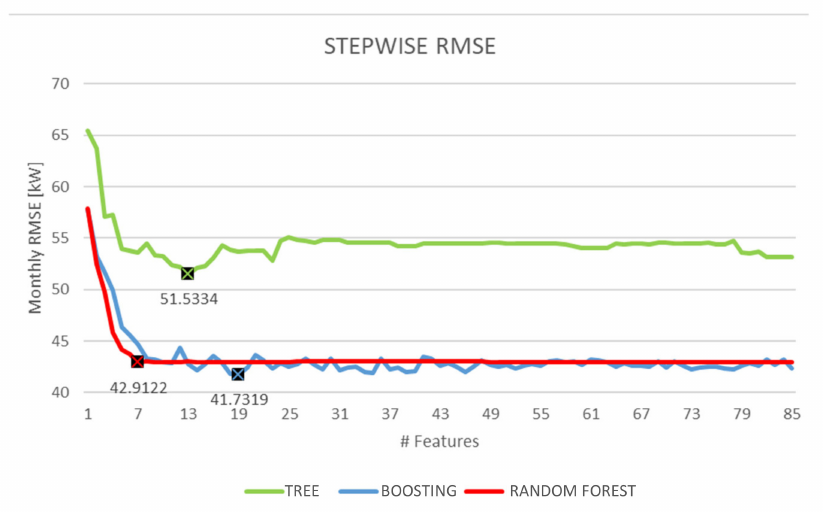
Figure 10. Monthly RMSE trend using features sequentially in order of